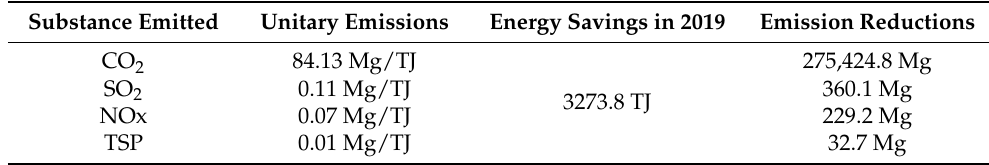
Table 3. The total potential for a reduction in the emissions in the GZM Metropolis. Source: Own elaboration based on data from studies of Hubgrade in Warsaw as referred to the GZM emissions. Substance